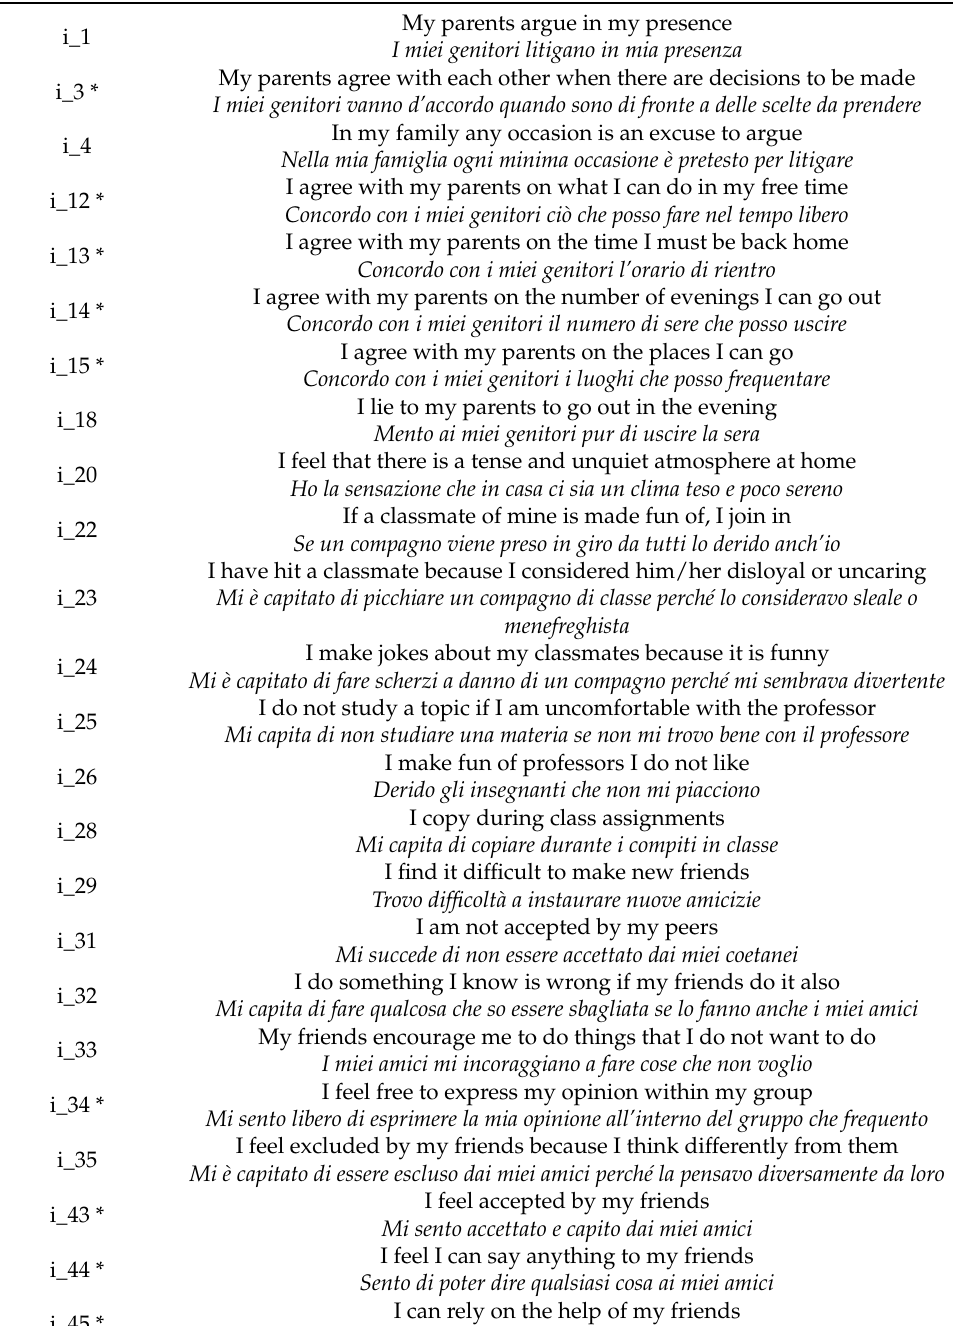
Table A1. The Family, Peers, and Externalising Behaviour in Adolescence